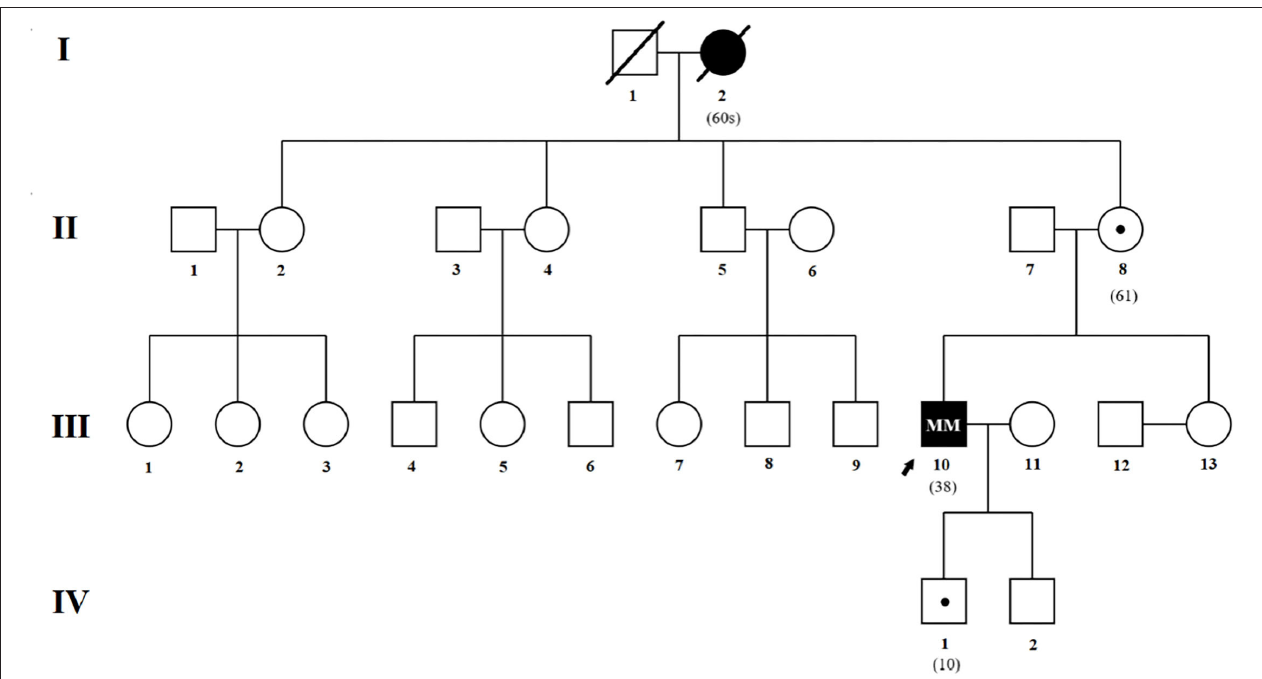
FIGURE 1 | Genealogical tree of the family. Affected patients and asymptomatic carriers are described in the text. Squares indicate males; circles, females; slash marks, deceased; arrow, proband; solid symbols, affected individual; small solid dot with square or circle, asymptomatic